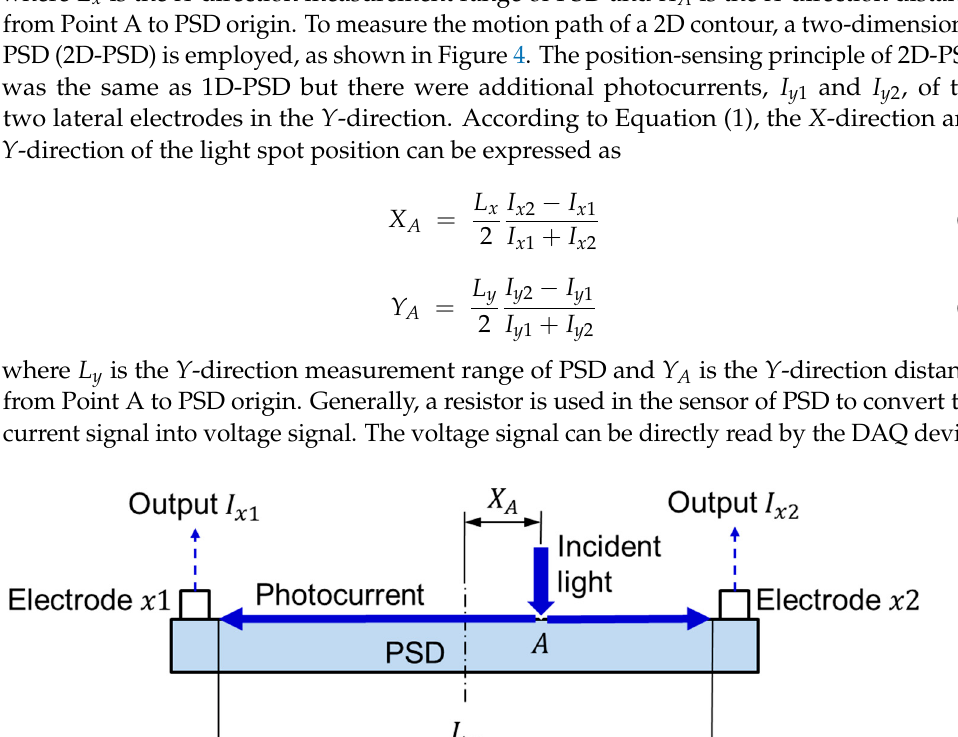
Figure 2. Optical path principle of the optical pickup head.